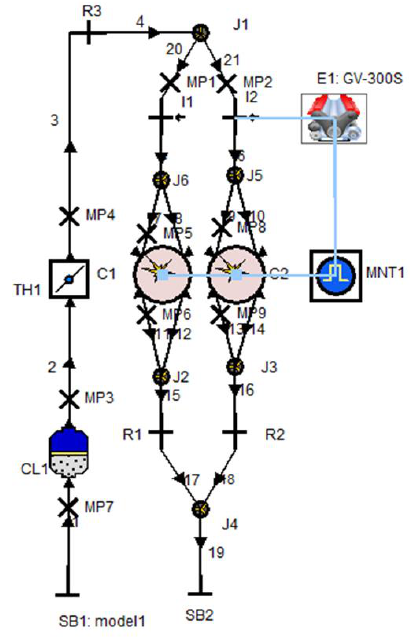
Figure 3. Simulation model.